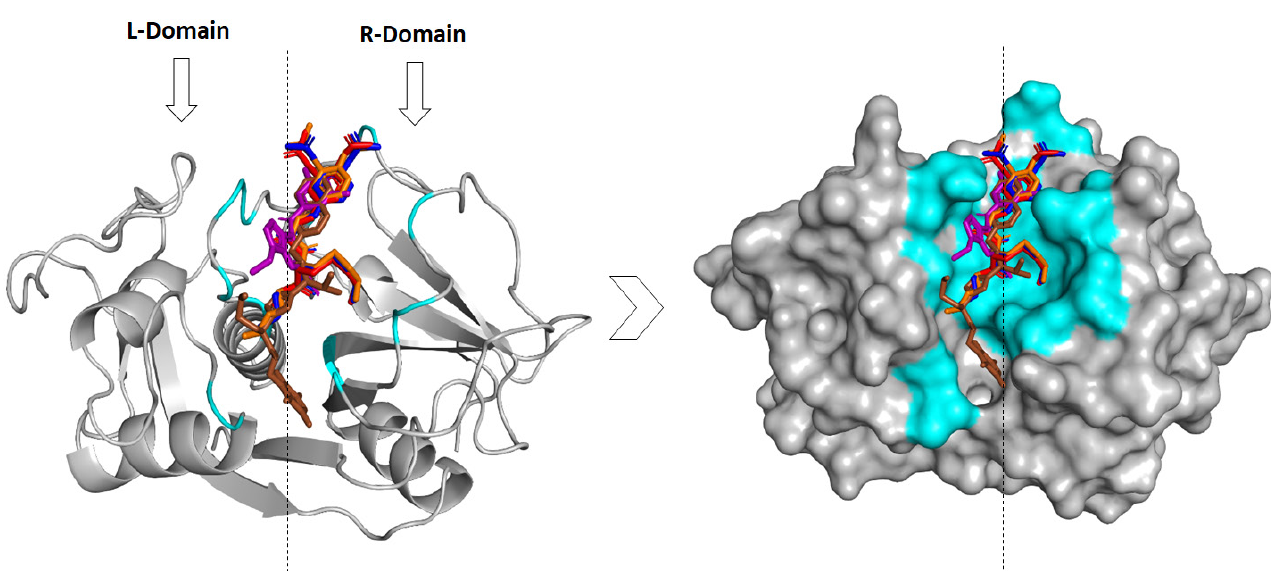
FIGURE 5 - Superposition of the best docked conformations of hybrids 1-3 and positive references within the cruzipain active site. Hybrids 1 ( in red ), 2 ( in blue ), 3 ( in orange ) and current inhibitors TFK ( in brown ) and Purine-nitrile ( in purple ). Critical aminoacids into cleavage site are represented in